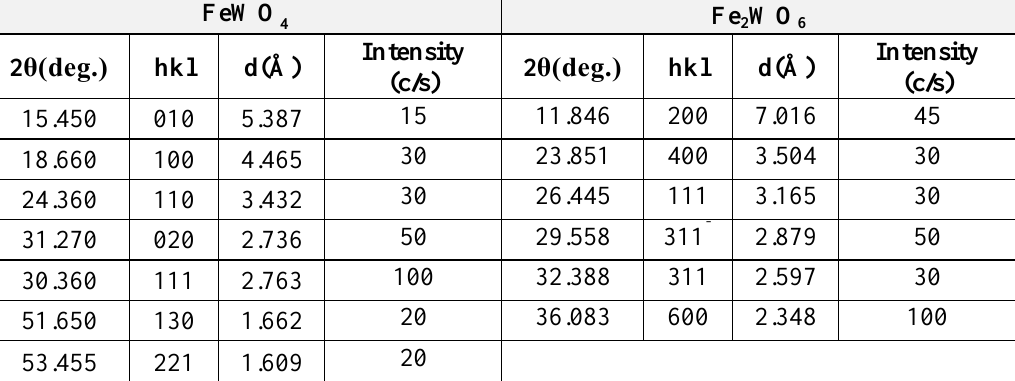
Fig. 2: XRD spectra of S2 sample. Table 4: Results data of XRD S2